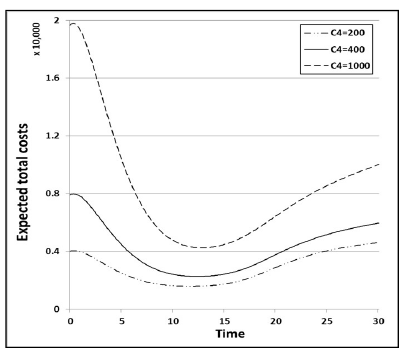
Figure 17. Expected total cost according to cost coefficient C 4 for the 2 nd condition.